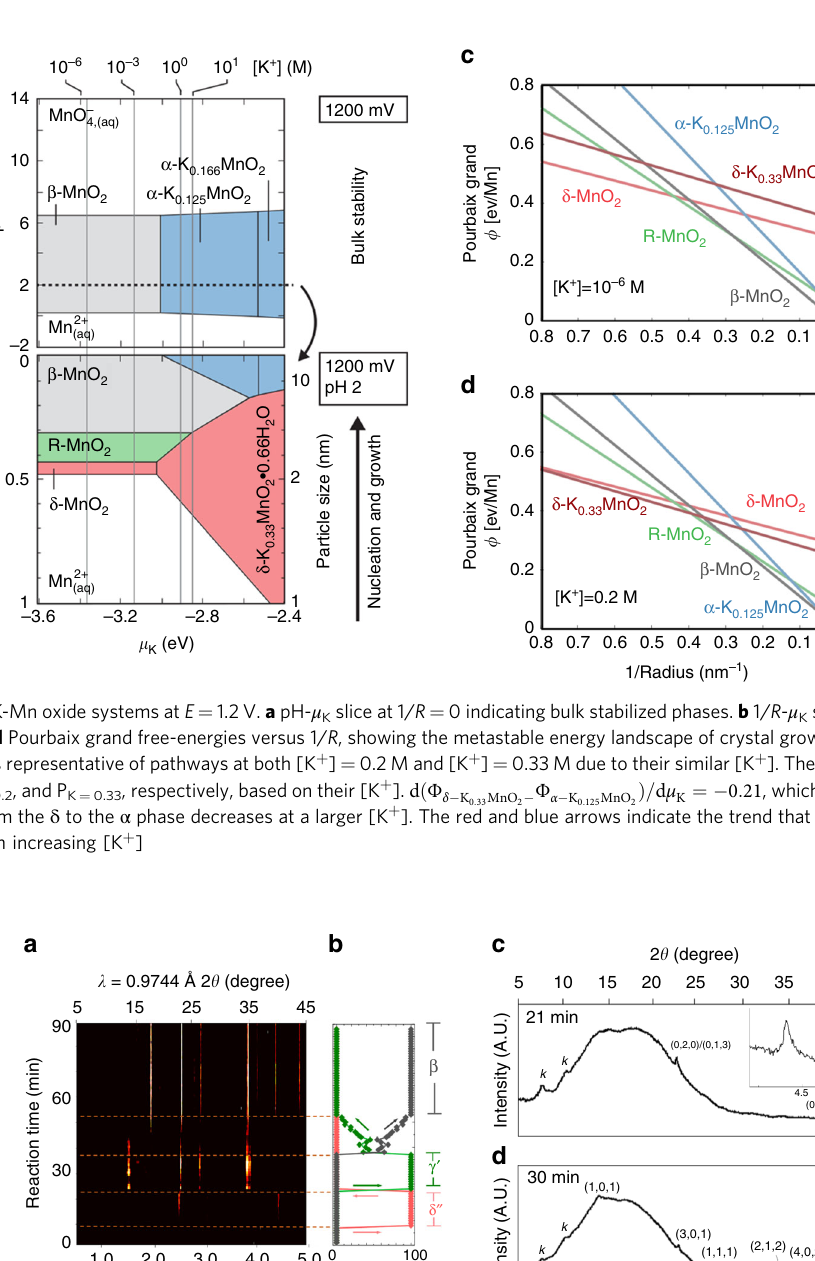
Fig. 3 In situ X-ray scattering analysis of P K = 0 . a The evolution of X-ray scattering pro fi les with time along P K = 0 . q is related to the diffraction angle ( θ ) and incident wavelength ( λ ) by q ¼ 4 π λ sin θ and λ = 0.9744 Å. b Phase fraction evolution calculated from the intensities of diffraction peaks in a . c – e X-ray scattering pro fi les of the δ ′′ ( c ), γ ′ ( d ), and β ( e ) phases, respectively. The inset fi gure in c shows the asymmetrical tail of the peak at q = 4.45 Å − 1 . The weak peaks around q = 0.9 and 1.2 are caused by a kapton fi lm covering the capillary reactor (marked by k in c – e ). The broad peak around q = 1.5 – 2.5 Å − 1 is caused by imperfect background subtraction (see Supplementary Notes 3 for details). f Structure of a pristine R phase. The γ ′ phase discussed in this paper is an R phase with a random amount of β (1 × 1 tunnel) intergrowth. g Re fi ned structure of the β phase (see Supplementary Notes 5 for re fi nement details)